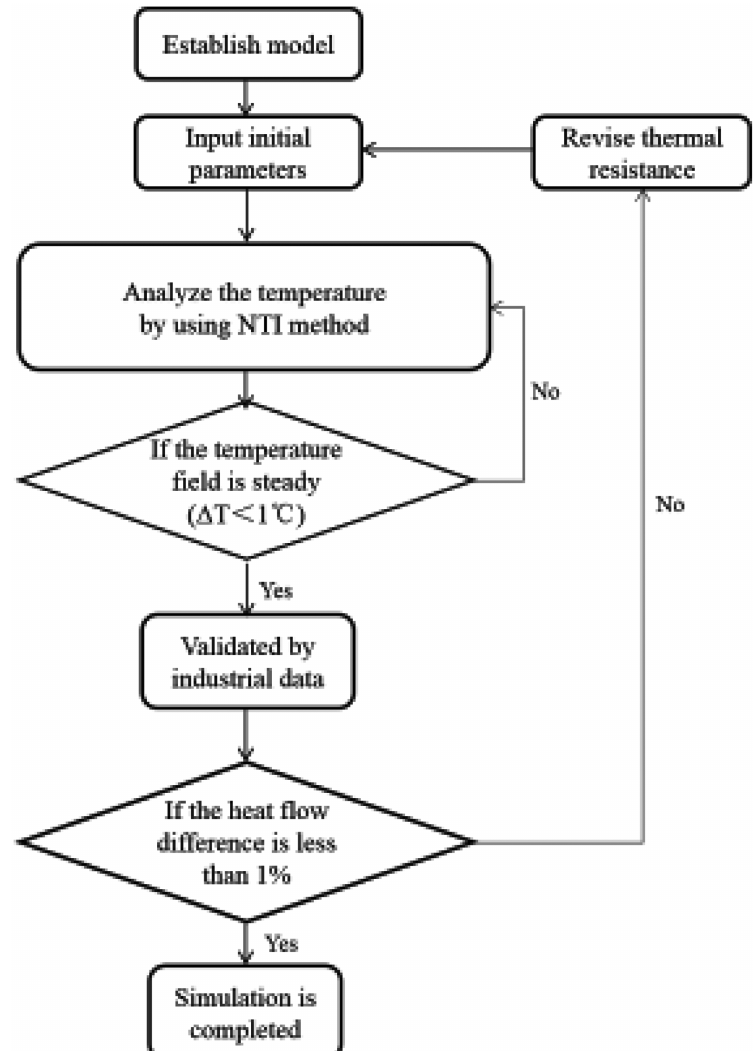
Figure 4: Flowchart of NTI calculation